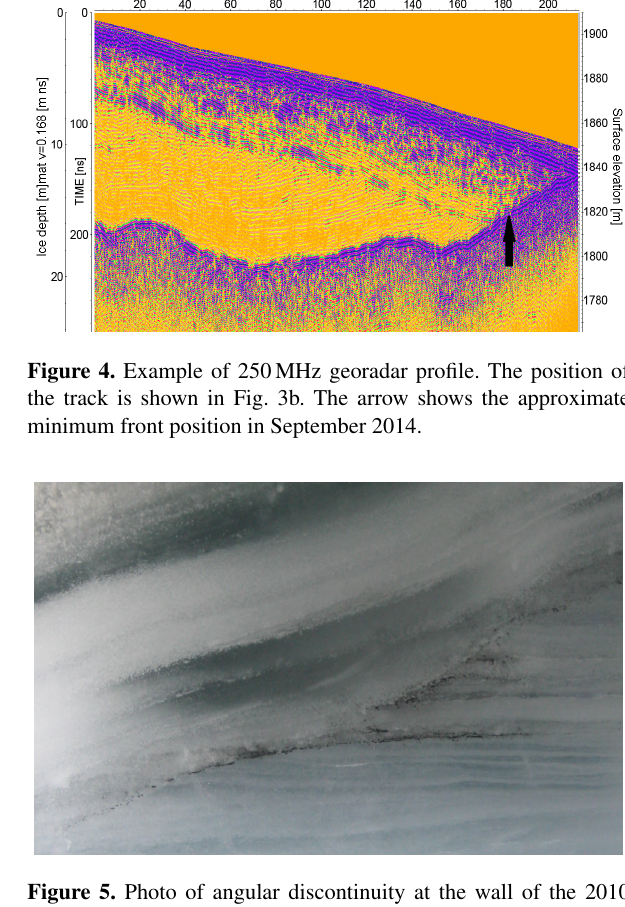
Figure 5. Photo of angular discontinuity at the wall of the 2010 ice tunnel, as also observed from the georadar data (Fig. 4). The upper layering is parallel to the surface of Juvfonne. Radiocarbon dating of the upper part showed modern age. Width of the picture is approximately 0.4m.